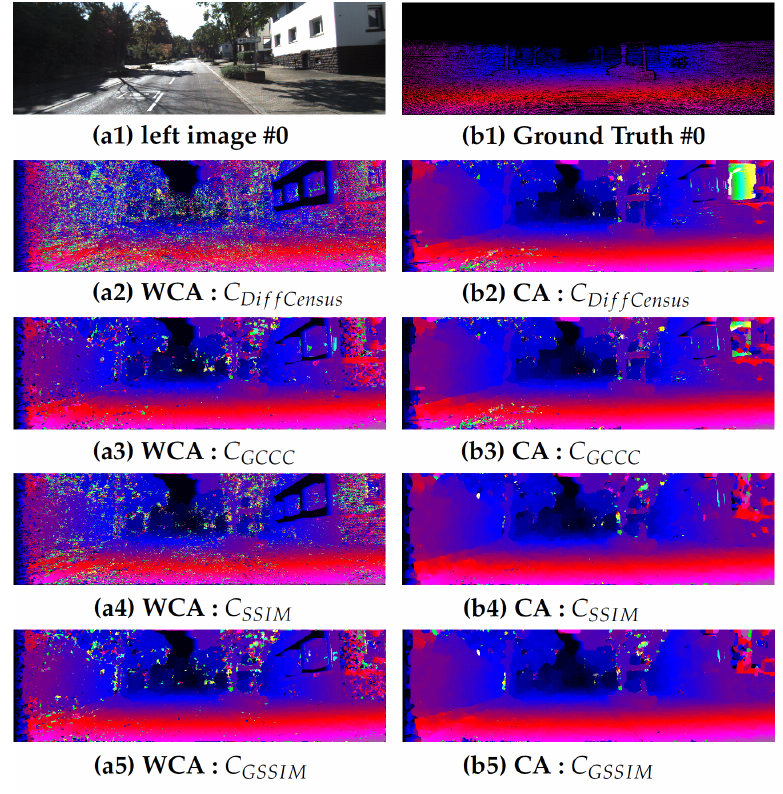
Figure 1. Disparity maps of #0 stereo pair from the KITTI 2012 dataset . The first column corresponds to left stereo ( a1 ) with its corresponding ground truth disparity map ( b1 ). The computed disparity maps are listed in the following lines corresponding to cost functions C Dif fCensus , C GCCC , C SSIM and C GSSIM , respectively. First column ( a ) correspond to the output obtained without the use of an aggregation method (WCA), while second column ( b ) are the output based on the adaptive aggregation method